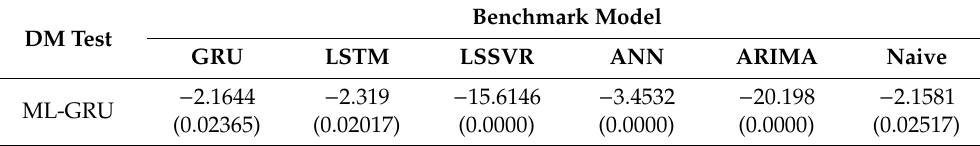
Table 5. The Diebold–Mariano (DM) test results for single models on WTI crude oil prices.